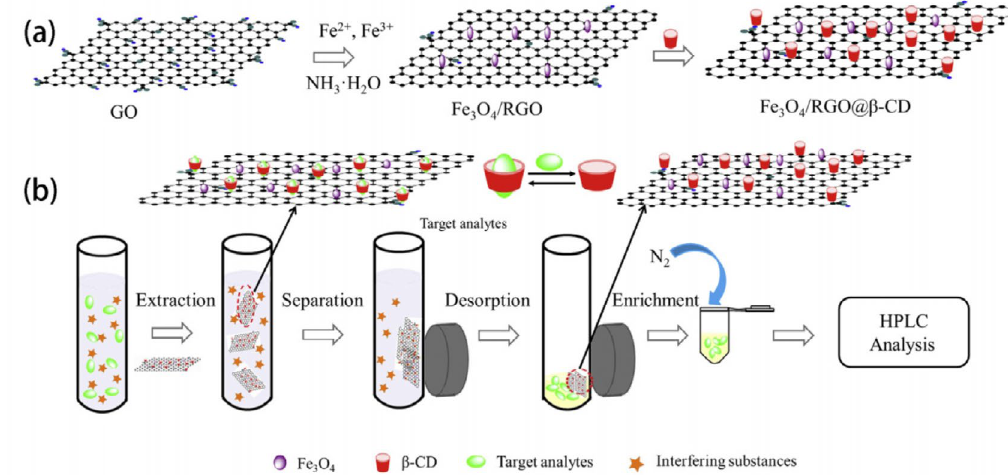
Fig. 4. Scheme of the synthetic route for Fe 3 O 4 /RGO@β-CD and their application for the MSPE [32].